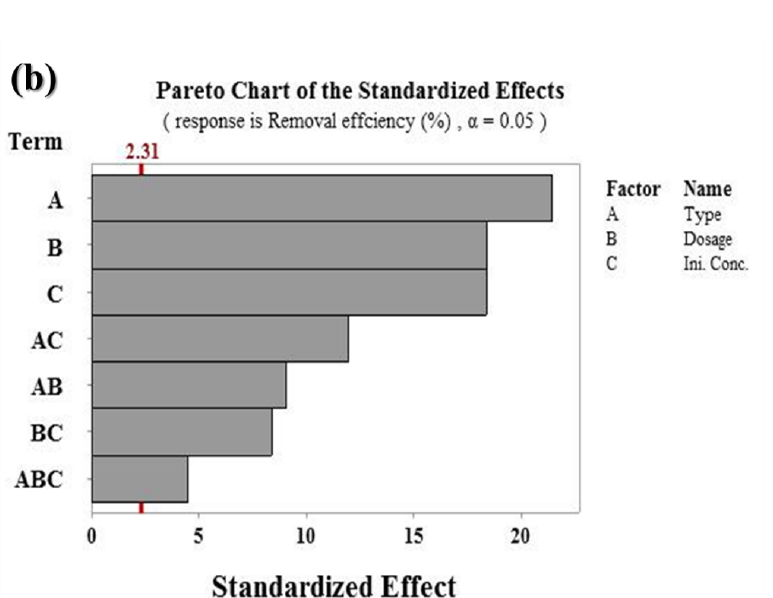
fixed MOF dosage, thus leading to a decrease in RE (see Equation (2)) [75 – 78].